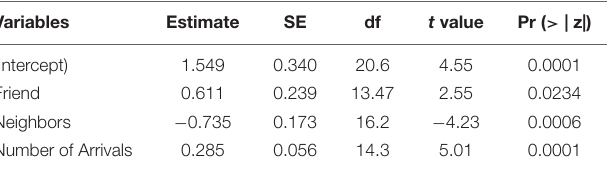
TABLE 3 | Results of the best LMM for the number of alarm calls of ignorant individuals encountering the snake. Variables